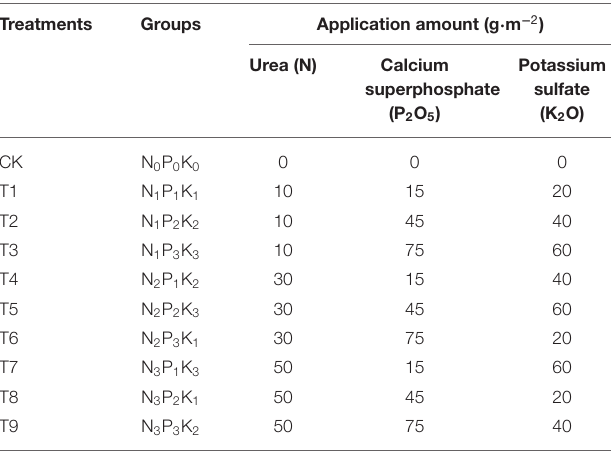
TABLE 1 | Types and amounts of fertilization in an L 9 (3 4 ) orthogonal experimental design. Treatments